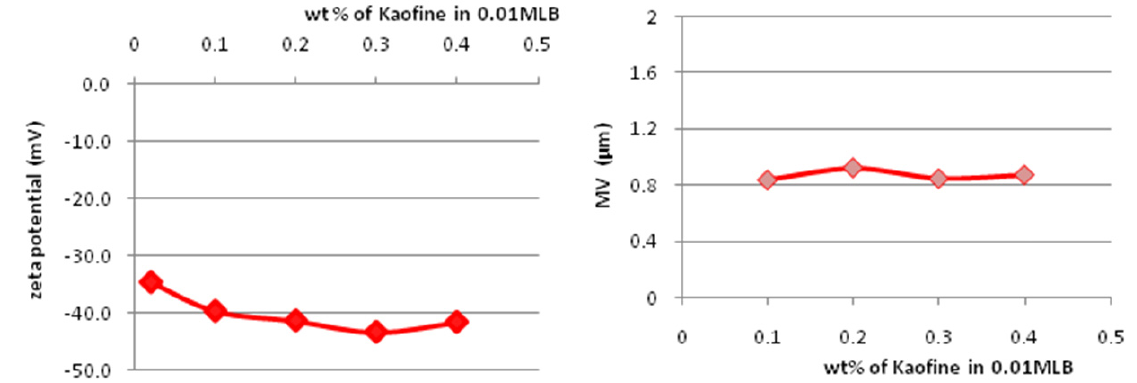
Figure 4. Zeta potential of Kaofine and kaolinite particles as a function of